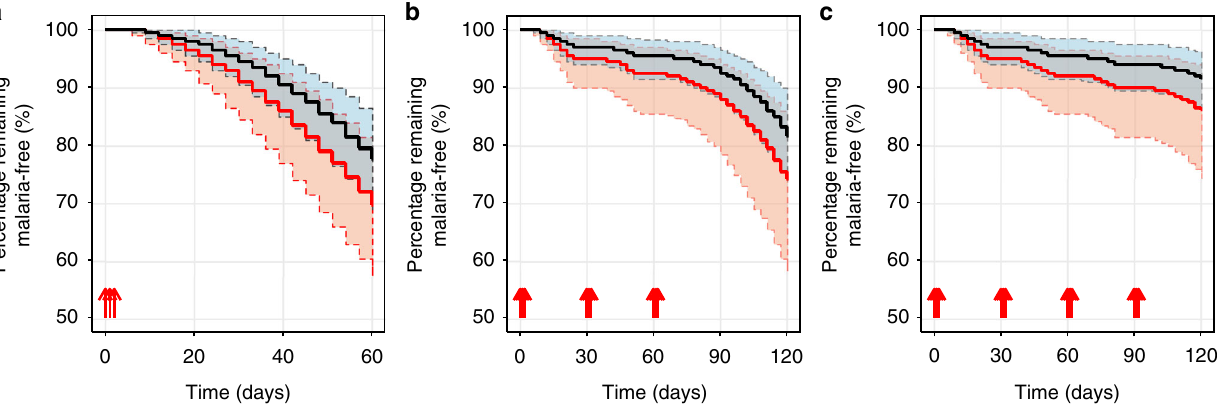
Fig. 3 Simulation of the expected pharmacodynamic outcome. a remaining malaria-free after a single treatment regimen, b remaining malaria-free after three rounds of monthly dose regimens (day 0, 30, and 60), and c remaining malaria-free after four rounds of monthly dose regimens (day 0, 30, 60, and 90). Red lines represent the standard WHO 2010 dosing regimen 52,43 and black lines the increased dosing regimens according to the revised WHO 2015 recommendation 26 in children (4 – 20 kg; n = 200 individuals per body weight, 100 replications). Solid lines represent the predicted median survival estimate of the Kaplan – Meier plot and shaded areas represent the 95% prediction intervals. Upward red arrows represent the time of